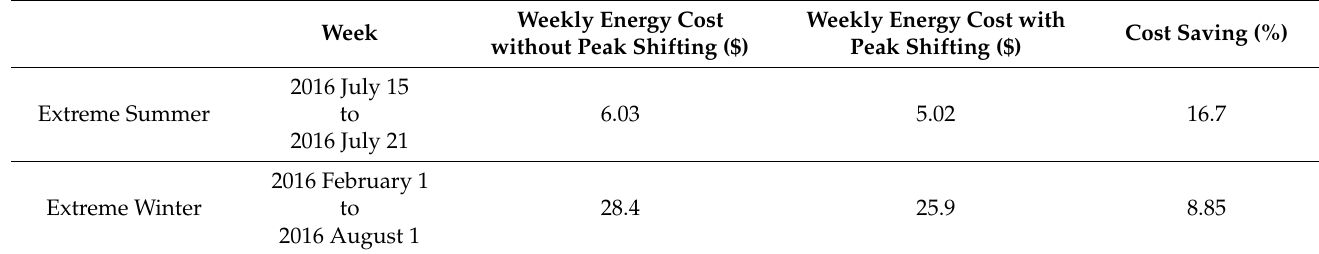
Table 5. Weekly energy cost savings in nanogrid through peak shifting. Weekly Energy Cost Weekly Energy Cost Week without Peak Shifting ($)